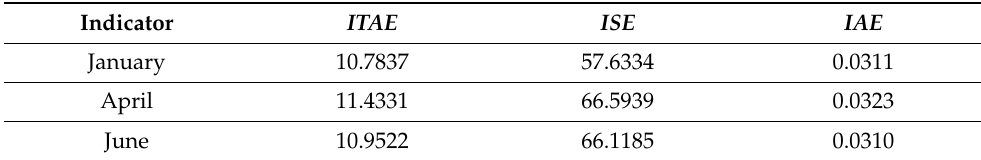
Table 2. Performance indicators in the south of Valle de Aburrá.